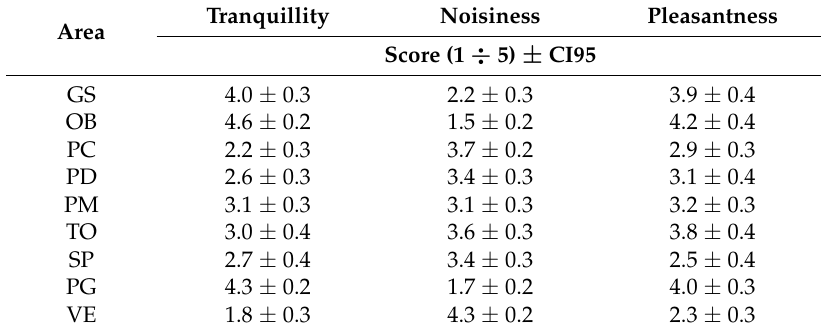
Table 8. Tranquillity, noisiness and pleasantness scores obtained by laboratory